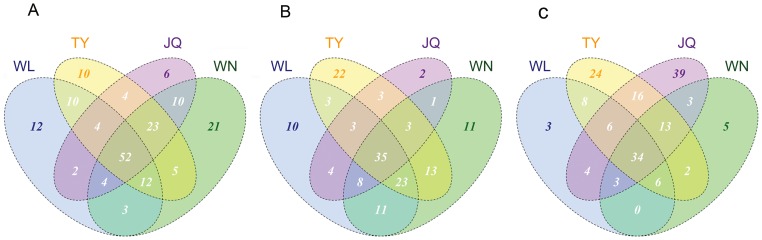
Venn diagram showing the unique and shared OTUs (3% distance level).(A) Upper active layer (30–40 cm, including samples of 1300, 2300, 3300 and 4300), (B) Lower active layer (70–80 cm, including 1500, 2500, 3500 and 4500) and (C), Permafrost table (below 130 cm, including 1600, 2600, 3600 and 4600) libraries. WL: Walagan, WN: Walagan North, TY: Tayuan, JQ: Jiagedaqi.